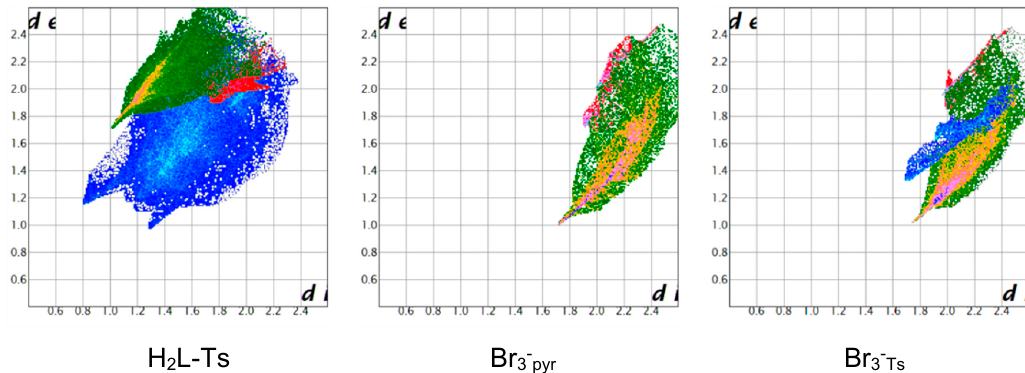
Figure 10. Ligand (H 2 L-Ts) 2 + and Br 3 − fingerprint plots. H-bond tip displayed in green hue. Anion- π contacts shown in red. Other interactions in standard fingerprint plot colouring. In the case of Br 3 − interacting with tosyl group (Br 3 − Ts ), the blue region is associated with the unusual Br 3 − ⋅⋅⋅ NO 3 − contacts.